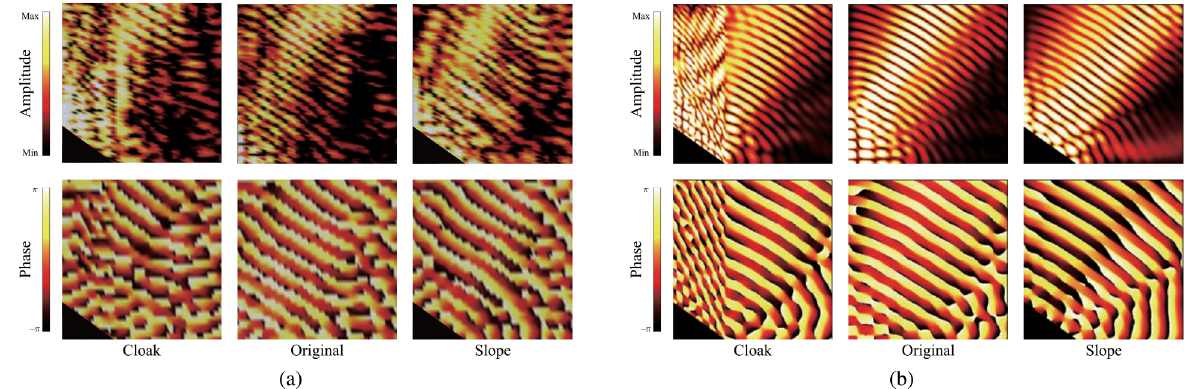
Fig. 5. Measured and simulated fi eld distributions for the incident angle of u inc = 60 (cid:4) (@18.3 GHz). (a) Measured results. (b) Simulated results by the circuit simulations. The upper and lower rows represent complex amplitude and phase distributions, respectively. The left, center, and right columns represent fi eld distributions for the cloak, the original area, and the slope,